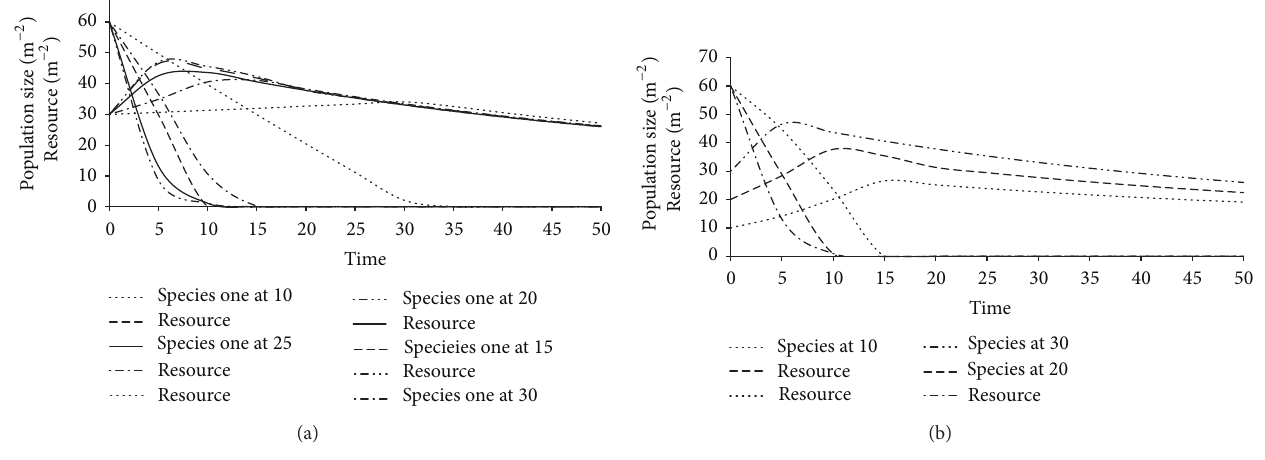
Figure 2: Behavior of the isoclines for one species and the resource at different temperatures; (a) shows the behavior of population size and the resource at temperatures 10 ∘ C, 15 ∘ C, 20 ∘ C, 25 ∘ C, and 30 ∘ C, respectively; (b) shows the behavior of population size and resource at different initial population size at temperature 25 ∘ C.